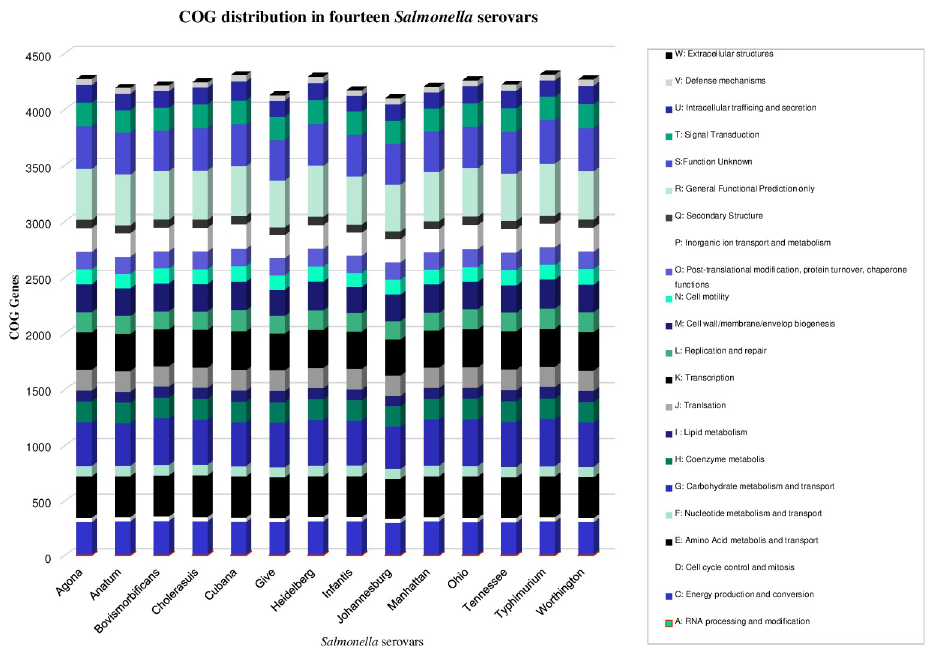
Fig 3. Distribution of functional classes of predicted genes according to the clusters of orthologous groups in Salmonella serovars. Different colors define different COG categories of